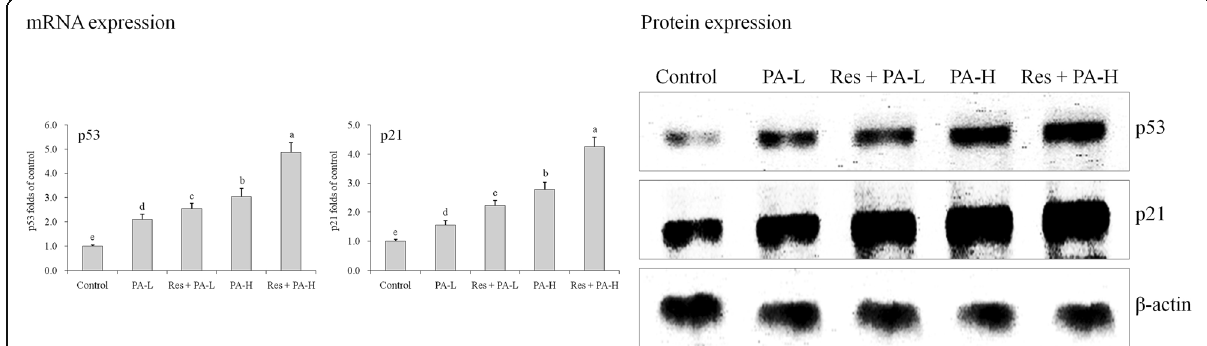
Fig. 7 The mRNA and protein expression of p53 and p21 in HepG2 human liver cancer cells. a-e Mean values with different letters over the bars are significantly different (P < 0.05) according to Dunnett ’ s post-hoc test. PA-L: 5 μ g/mL of paclitaxel; Res + PA-L: 10 μ g/mL of resveratrol +5 μ g/ mL of paclitaxel; PA-H: 10 μ g/mL of paclitaxel; Res + PA-H: 10 μ g/mL of resveratrol +10 μ g/mL of